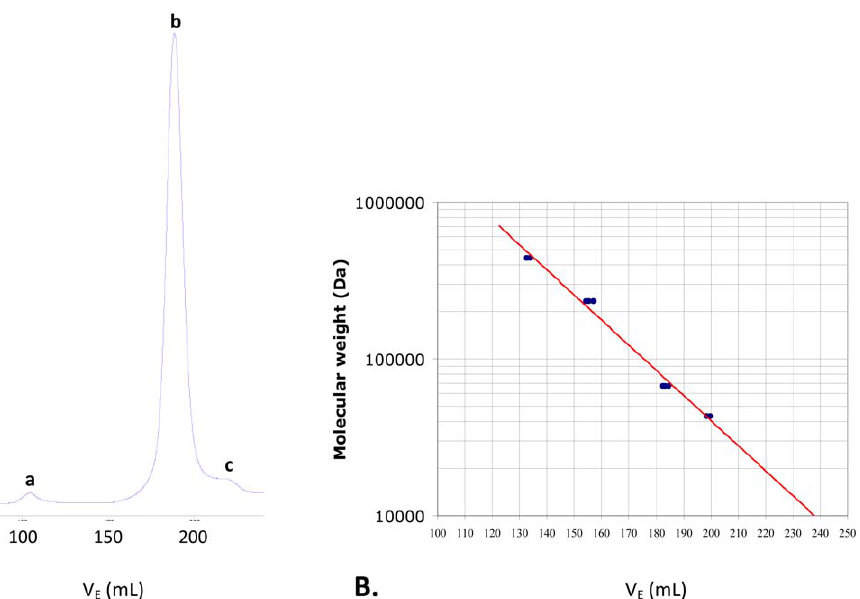
Figure 2. Oligomeric state of native ChrR and the mutants listed in Table 2 as determined by gel-filtration chromatography (Superdex 200 10/300). Panel A shows absorbance at 280 nm as a function of the elution volume, and Panel B is the calibration curve. The active enzymes are essentially tetrameric (peak b ), as the dimer fraction (peak c ) and protein aggregates (peak a ) are negligible.